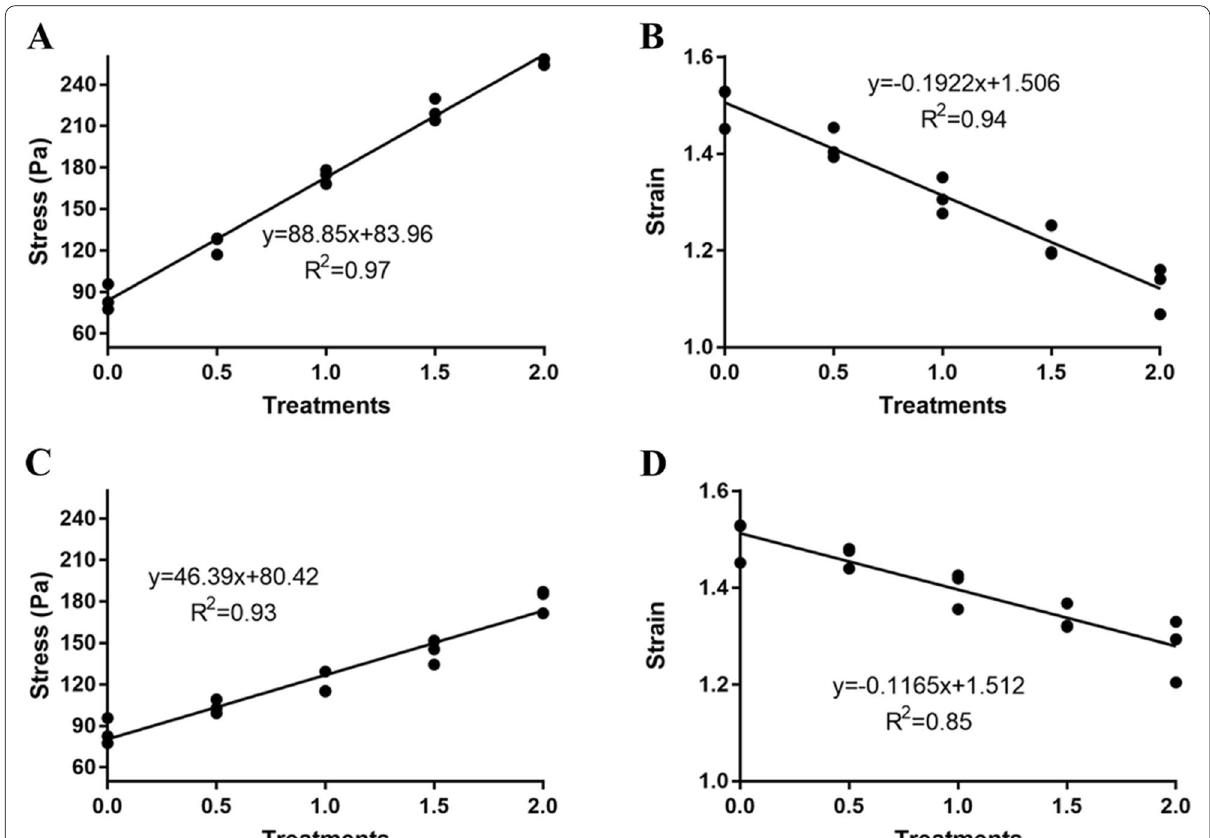
Fig. 1 The fracture stress and fracture strain of composite gel with modified starch and dietary fiber addition. The fracture stress ( A ) and fracture strain ( B ) of composite gel with dietary fiber addition. The fracture stress ( C ) and fracture strain ( D ) of composite gel with modified starch